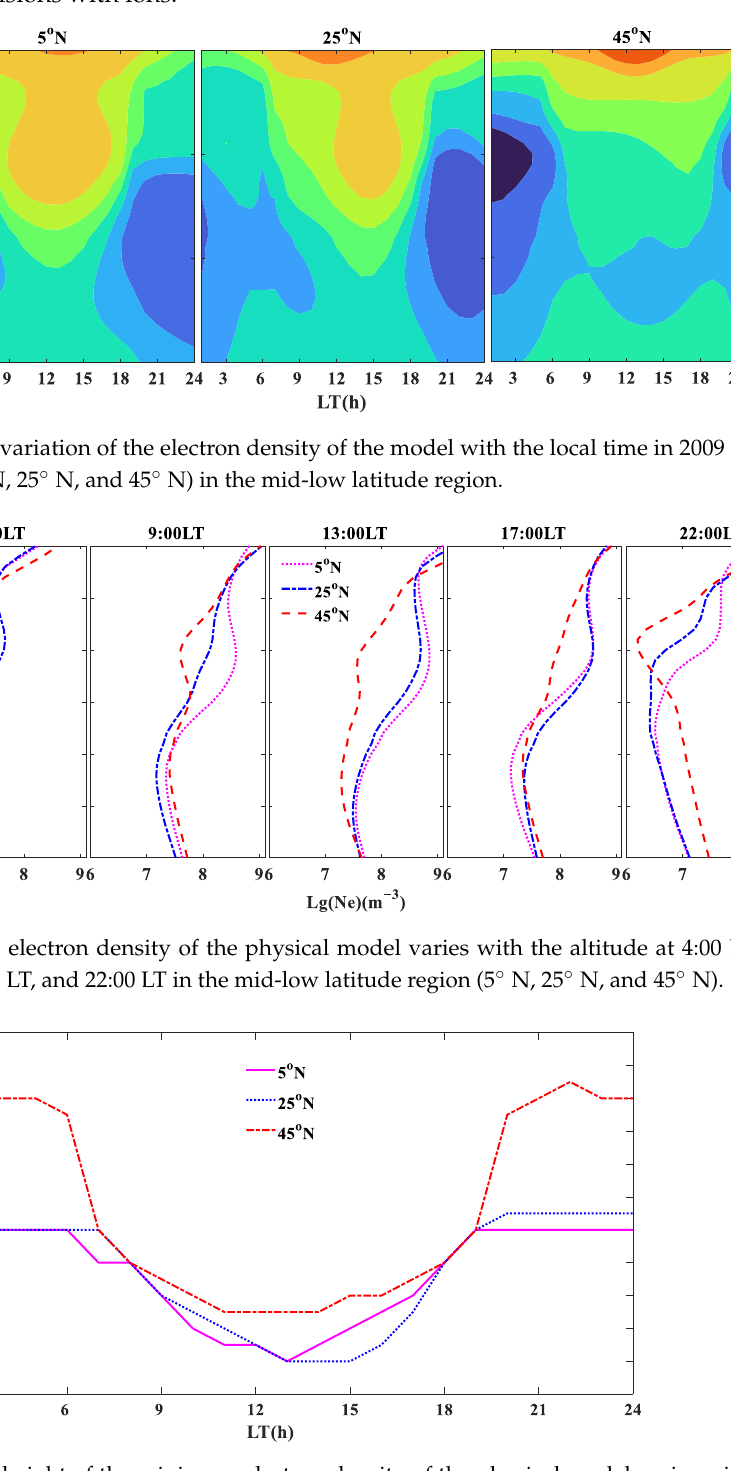
Figure 7. The height of the minimum electron density of the physical model varies with the local time in the mid-low latitude region (5°N, 25°N, and 45°N).